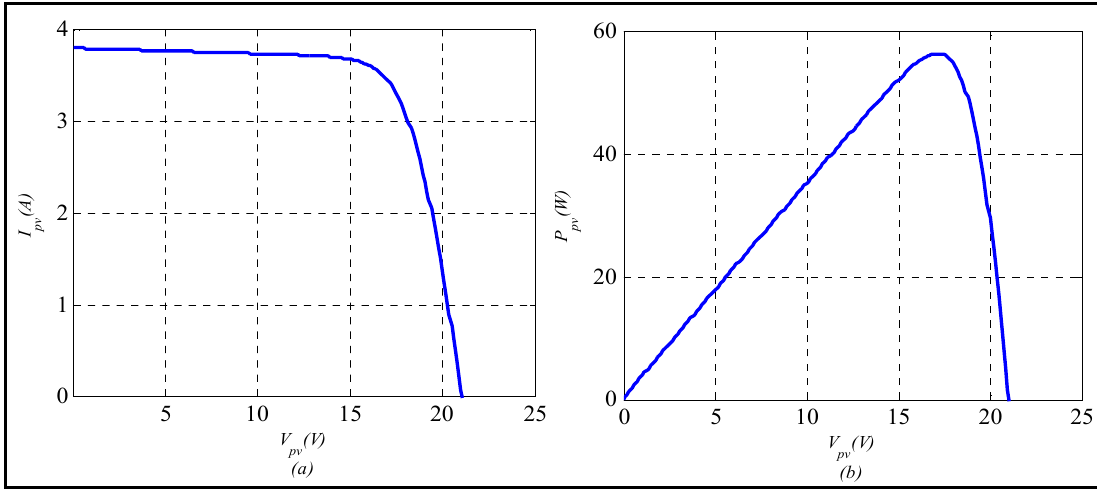
Figure 5. Typical PV characteristics under STC: ( a ) I = f(V) and ( b ) P = f(V).